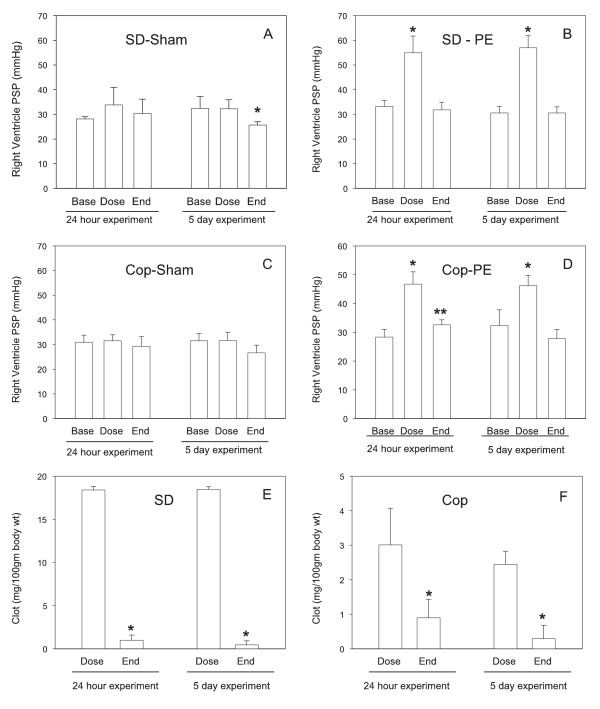
Hemodynamic and clot content measured at the baseline (base), immediately after dosing with clot (Dose) and at the end of the 24 hour or 5 day experiment in Sprague-Dawley (SD) or Copenhagen (Cop) strains of rats. Animals were treated with vehicle (Sham) or with pulmonary embolism (PE) injections. Values are mean ± standard error, where n = 10 in the SD and 4-5 in Cop experiments. *Significantly different from Base (RM ANOVA, t-Test). **Significantly different from Base and from Dose (RM ANOVA, t-Test).